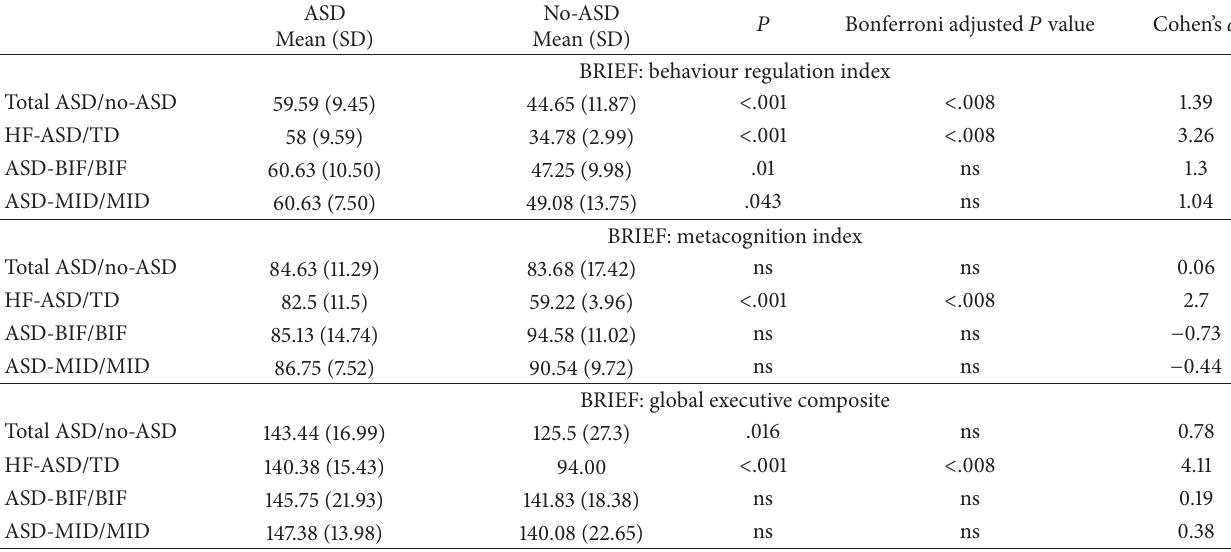
Table 4: Means, SD, and statistically significant differences ( 𝑡 test; Bonferroni correction: 𝑃 ≤ .00625 ; Cohen’s test) obtained from experimental and control groups at BRIEF-Parent